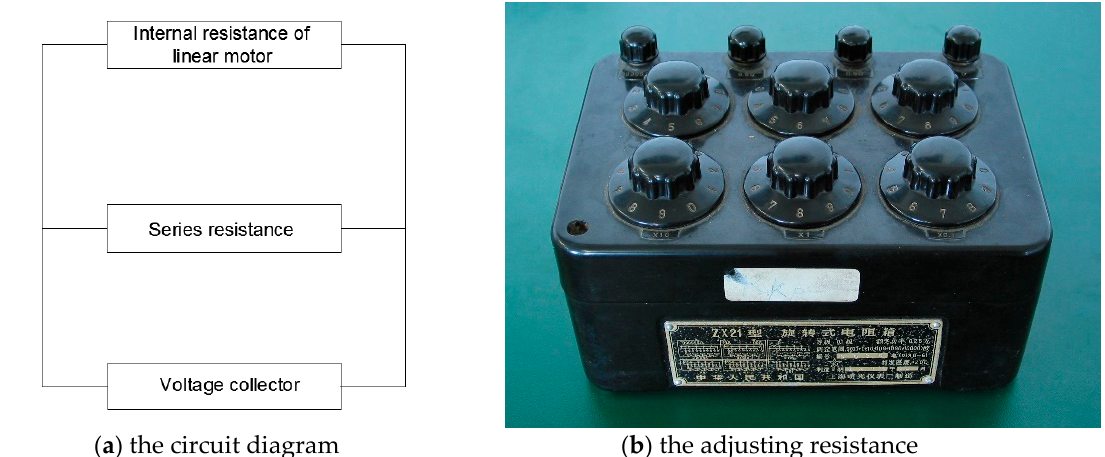
Figure 8. The circuit diagram and resistance box.